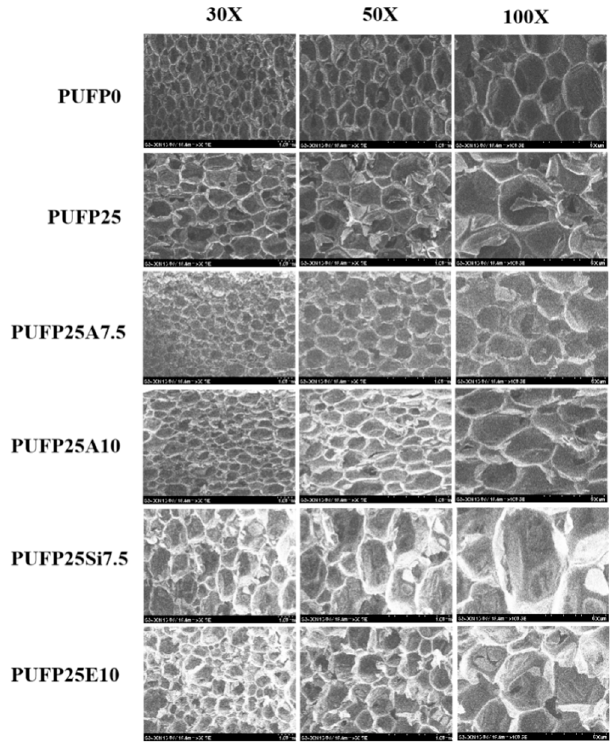
Figure 7. SEM images of RPUF in different magnifications.